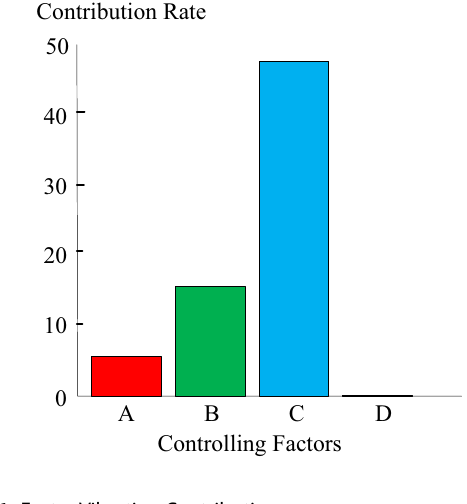
Fig. 16 Factor Vibration